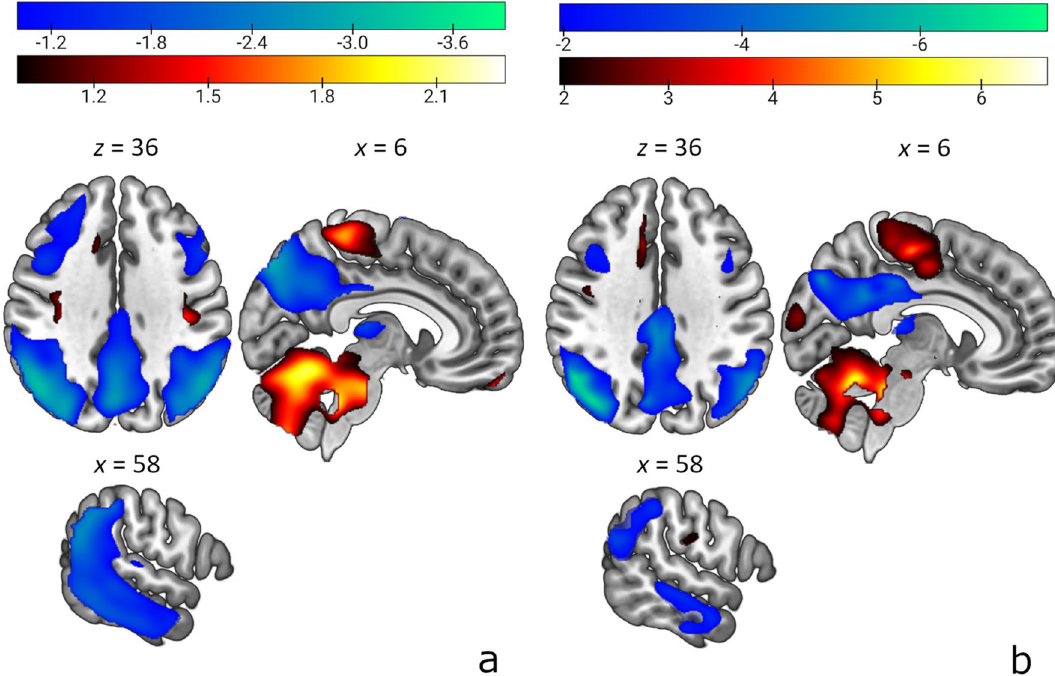
Figure 1. Alzheimer’s disease-related pattern (ADRP) and maps of inverse coefficient of variation overlaid on T1-weighted magnetic resonance template images. ( a ) The ADRP was characterized by relatively reduced metabolic activity (color-coded green to blue) in temporoparietal cortices, thalami, posterior cingulate and precuneus which co-varied with relatively increased metabolic activity (color-coded red to yellow) in the cerebellum. ( b ) The topography of ADRP was reliable as estimated by a voxel-wise bootstrapping algorithm. The display represents the maps of inverse coefficient of variation thresholded at z =|1.96|, p < 0.05.